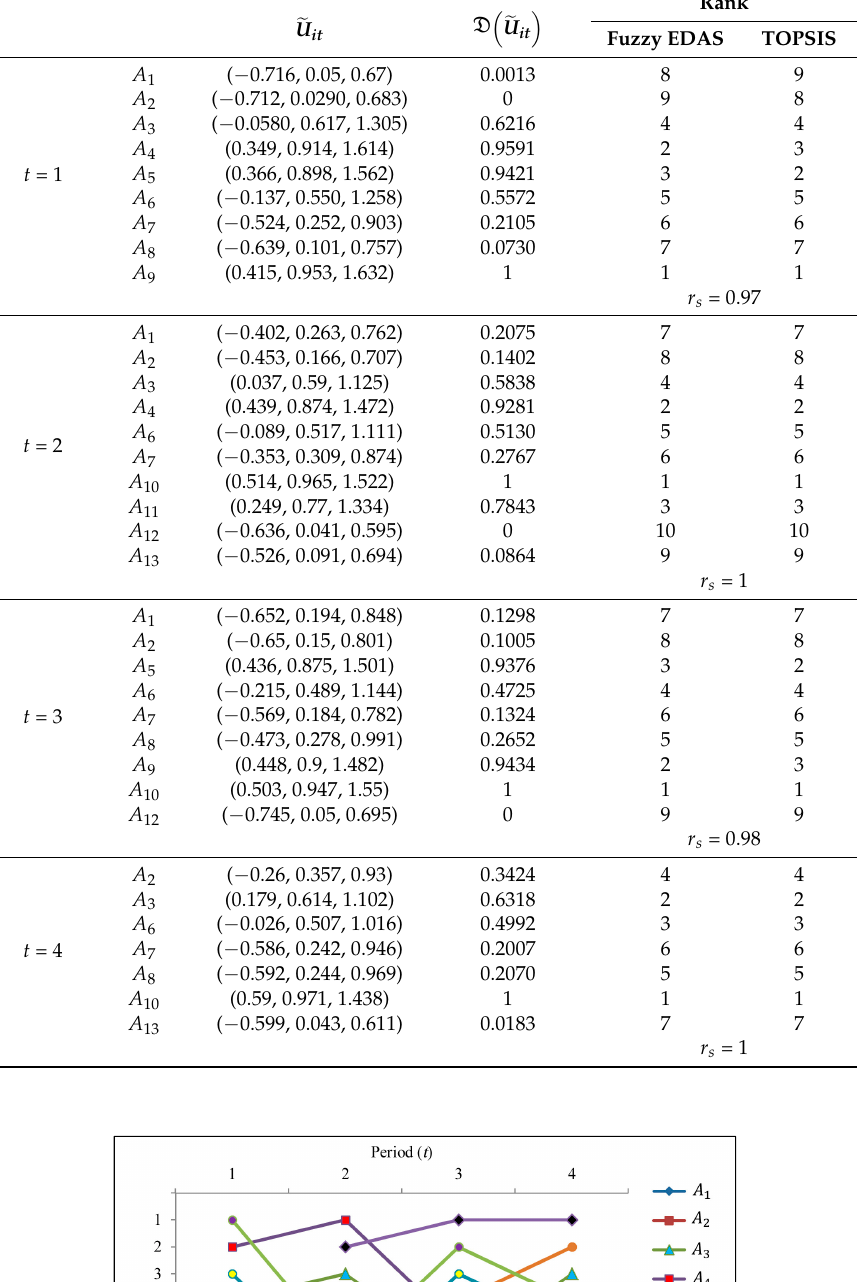
Table 7. The overall performance scores and ranking results at each period.